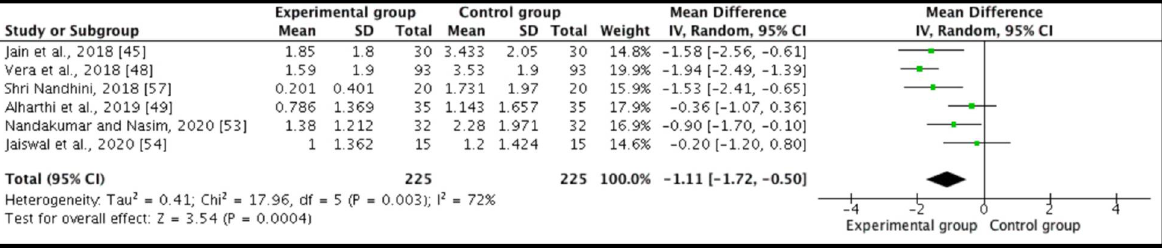
Table 2. Certainty of evidence. Question: Is intracanal cryotherapy effective in reducing postoperative endodontic pain compared with a room temperature irrigant (Control)?; Setting: A dental clinic; Participants: Adult patients (≥18 years old) with permanent teeth that have pulpal or periradicular pathosis; Intervention: Final irrigation with a cold irrigant; Comparator: Final irrigation with an irrigant at room temperature.